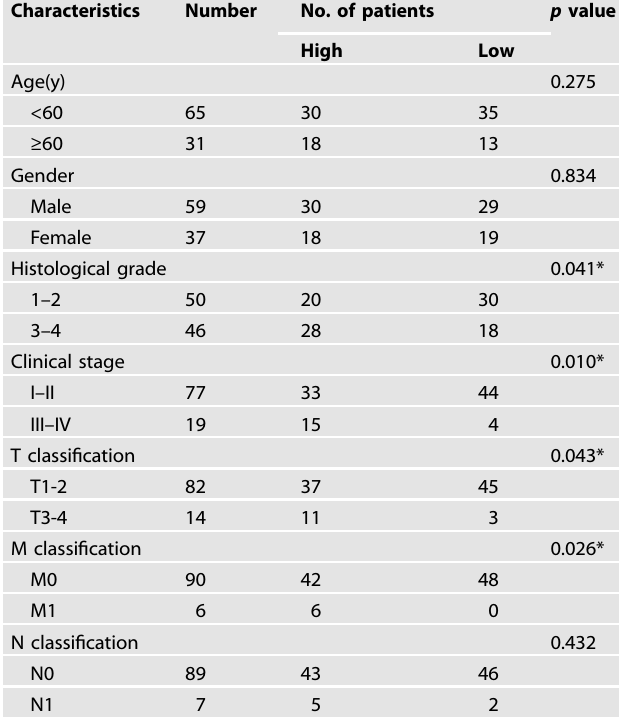
Table 1. Correlation between circPPP6R3 expression and clinical features in